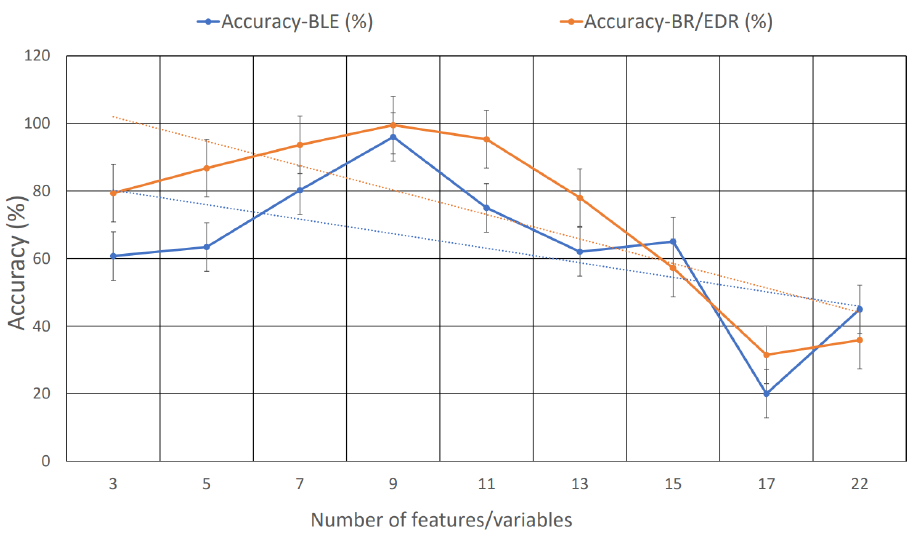
Figure 3. Accuracy of the model based on several features. Based on the varying accuracy of the number of features, we chose nine features from the dataset to train and test the